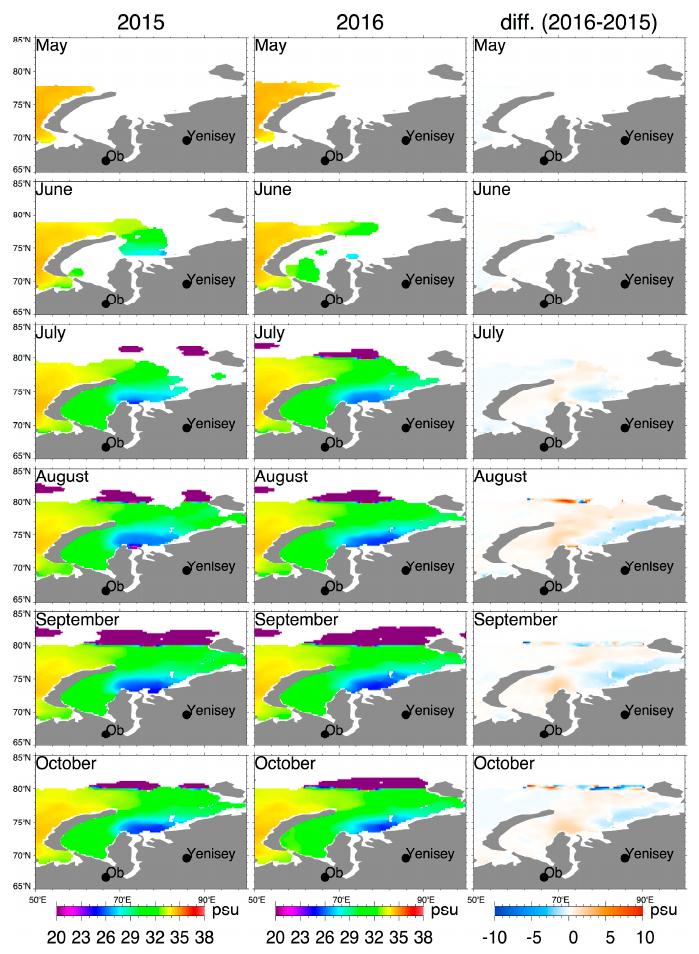
Figure 7. Similar as Figure 6 for HYCOM SSS.